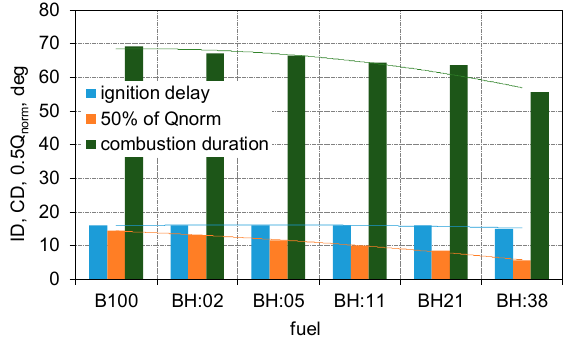
Figure 4. Combustion stages: ignition delay, time of 50% of heat release and combustion duration.